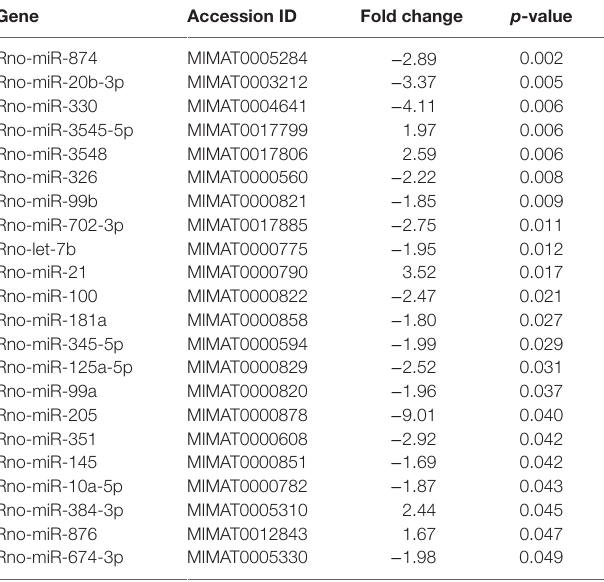
(a) Volcano plot showing the relationship between fold change and significance between the two groups. The horizontal dashed line indicates cutoff for significance p < 0.05 ( − log10 p -value > 1.3) and the vertical lines for fold change ≥ 1.5/ ≤− 1.5. (B) Heatmap showing unsupervised hierarchical clustering of differentially expressed miRNAs in gut between control ( n = 3) and aGvHD ( n = 2) animals. Each column represents an individual rat. Relative fold change is indicated by the color scale (red: high; blue: low). (c) qRT-PCR analysis of miRNA expression in small intestines of control ( n = 6) or aGvHD ( n = 6) rats. Samples were normalized to endogenous controls and expression levels reported as log of 2 −ΔΔ Ct ± SD. Significance was calculated using the Student’s t -test (two-tailed) with Welch’s